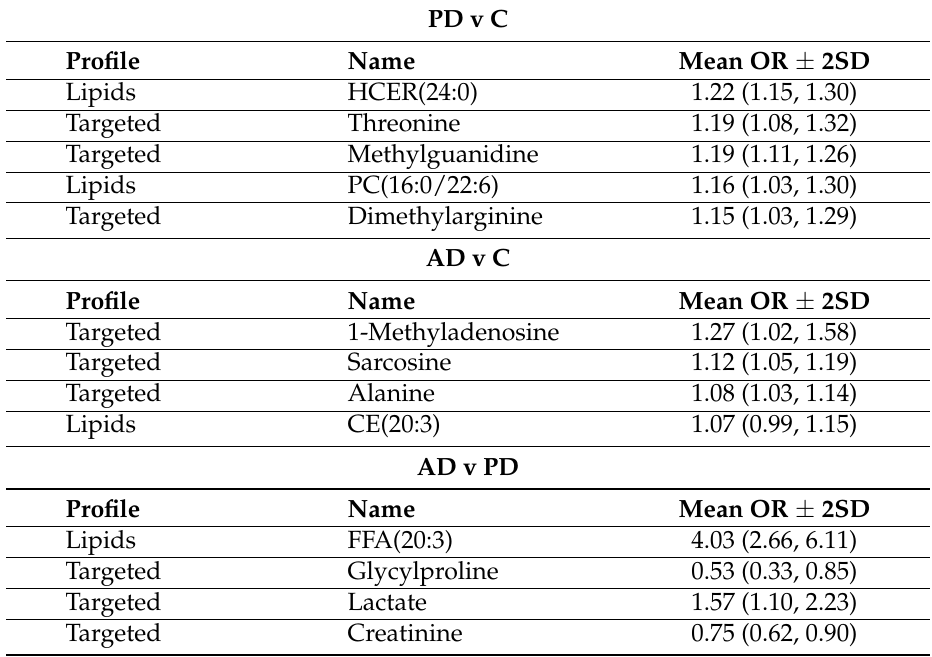
Table A4. Targeted metabolites and lipids appearing in all leave one out models, for each modeling